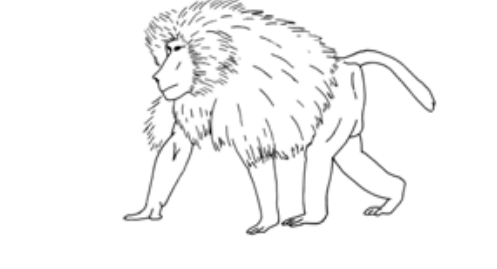
Box 6: Locomotor characteristics of Hamadryas